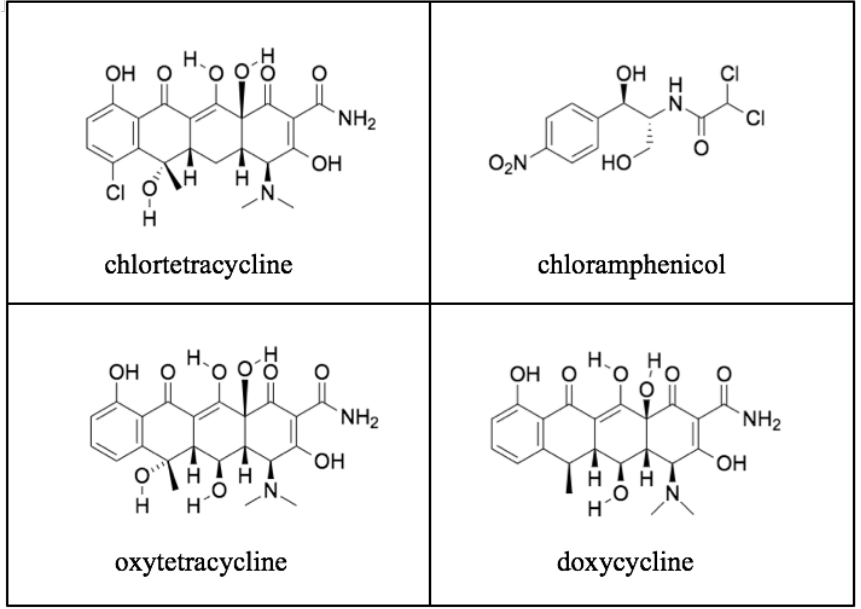
Figure 12. The New Antibiotics: chloramphenicol (1947), chlortetracycline (1948), oxytetracycline (1948), and doxycycline, synthesized in two steps from oxytetracycline, in 1967.